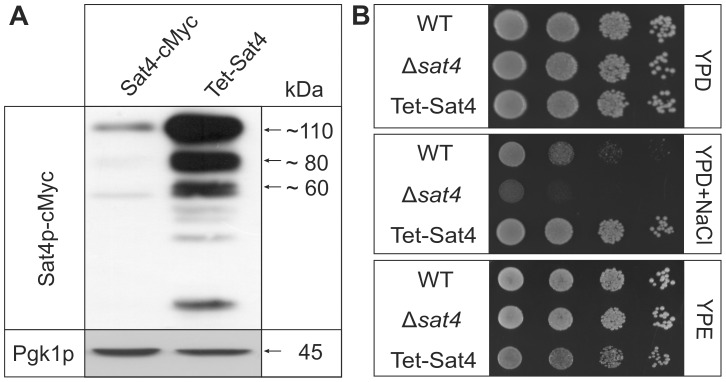
Overexpression of Sat4p.(A) For verification of TET-promoter driven overexpression of Sat4p, 50 µg of total protein extract from the strains Sat4-cMyc and Tet-Sat4 were separated by 10% SDS-PAGE and subjected to Western blot analysis using a cMyc-antibody. Detection of Pgk1p served as loading control. (B) Phenotypes were analyzed by dropping a dilution series (104 to 101 cells) of wild type (WT), Δsat4 and Tet-Sat4 on solid YPD, YPD+1M NaCl or YPE. Growth was analyzed after cultivation at 30°C for two (YPD) to four (YPD+NaCl, YPE) days.